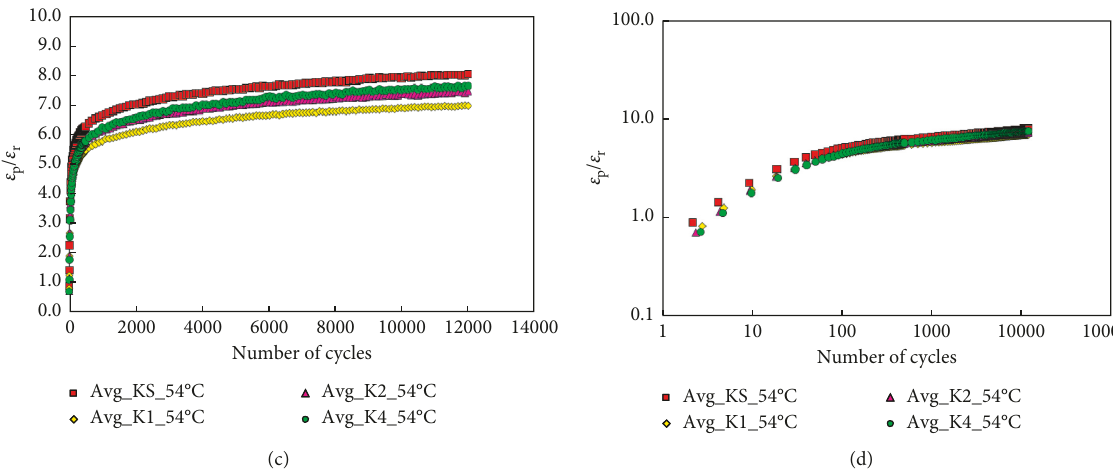
Figure 14: Comparison of permanent/resilient strain ratio growth of the four mixtures: (a) at 40 ° C in arithmetic scale; (b) at 40 ° C in log-log scale; (c) at 54 ° C in arithmetic scale; (d) at 54 ° C in log-log